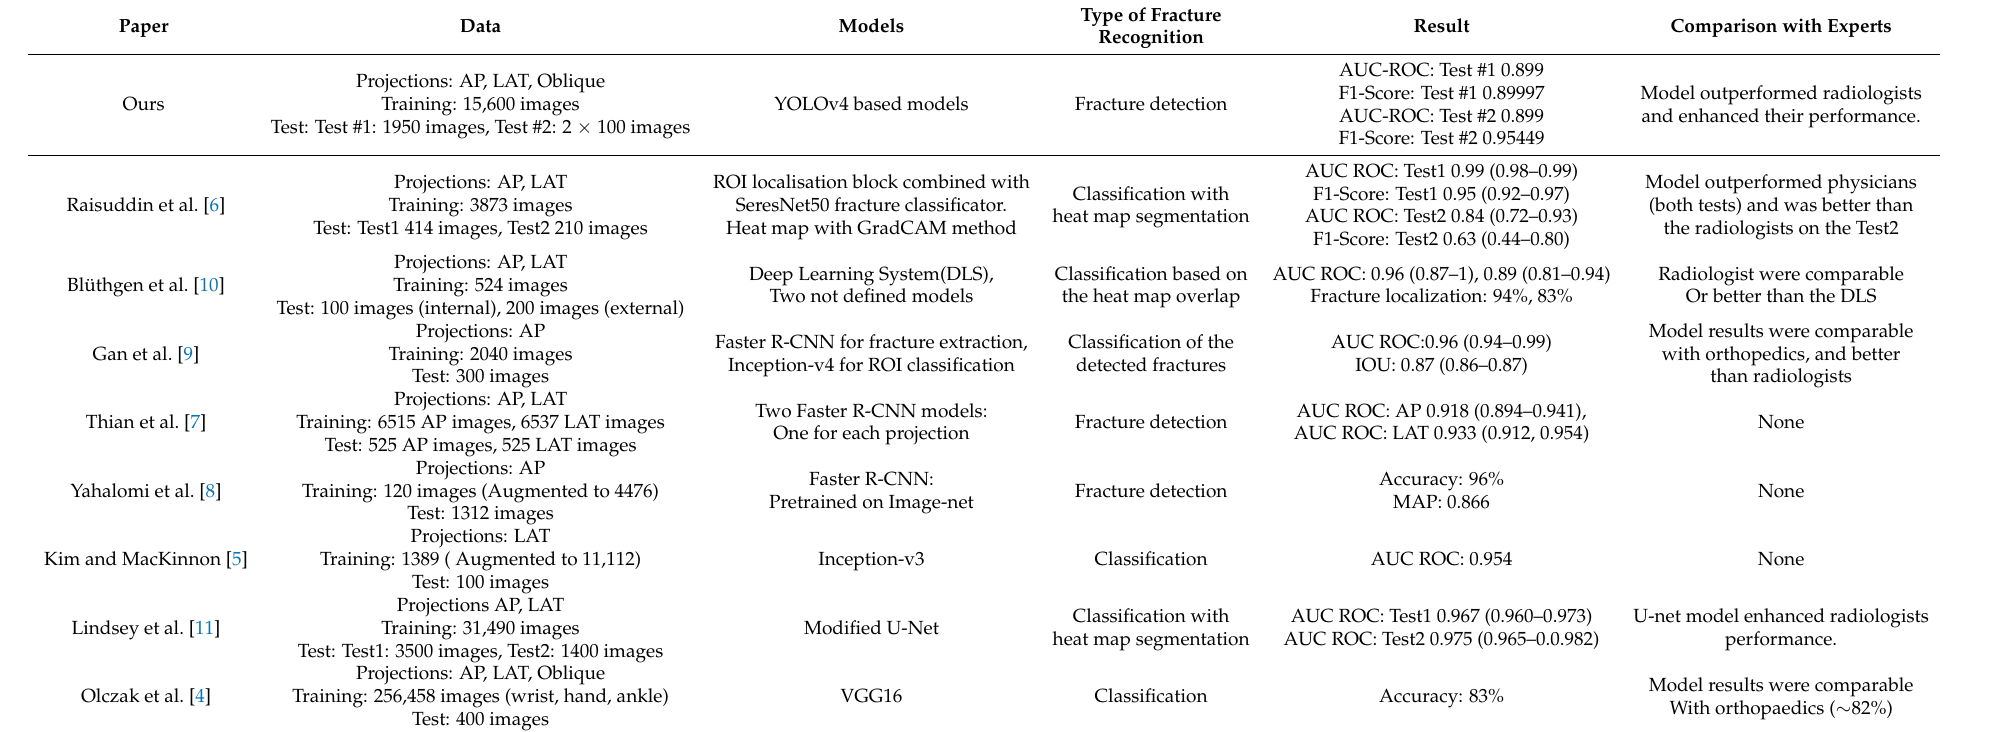
Table 7. Overview of related work with descriptive